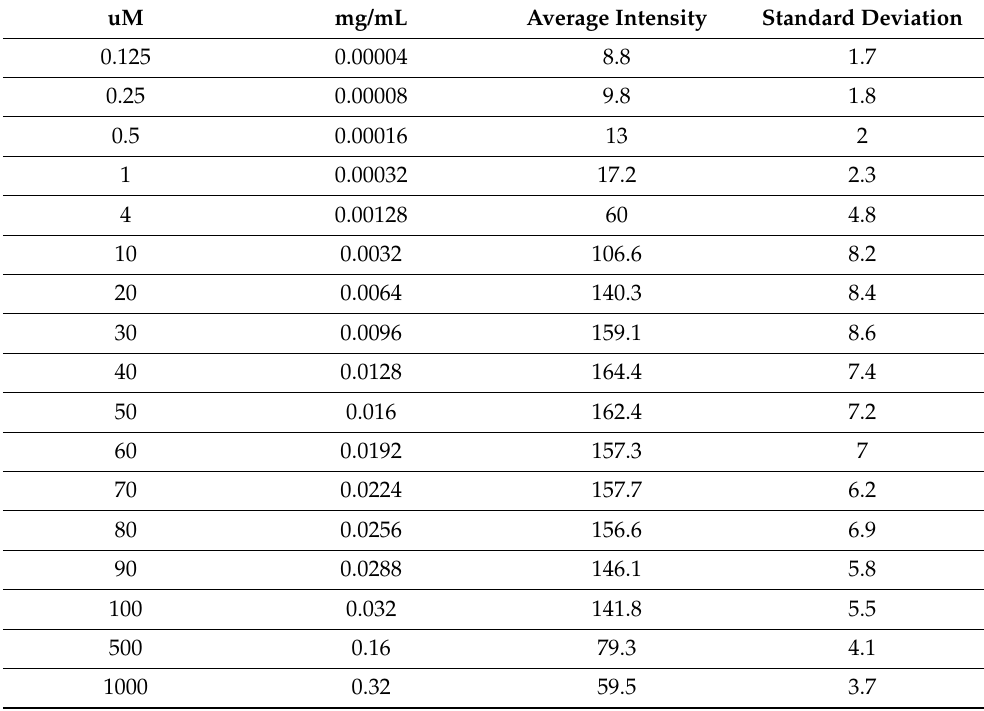
Table 4. Fluorescence intensity in different Methylene Blue